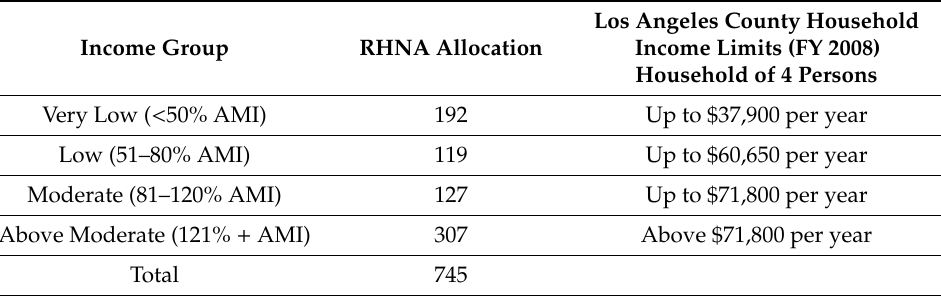
Table 1. The regional housing needs allocation for the city of Glendora (2006–2014) with the corresponding household income limits. In 2008, HUD determined that the median family income for Los Angeles County was $59,800. The area median income (AMI) for Los Angeles County is calculated as a percentage of HUD’s median family income and includes adjustments for families of di ff erent sizes [34]. Sources: